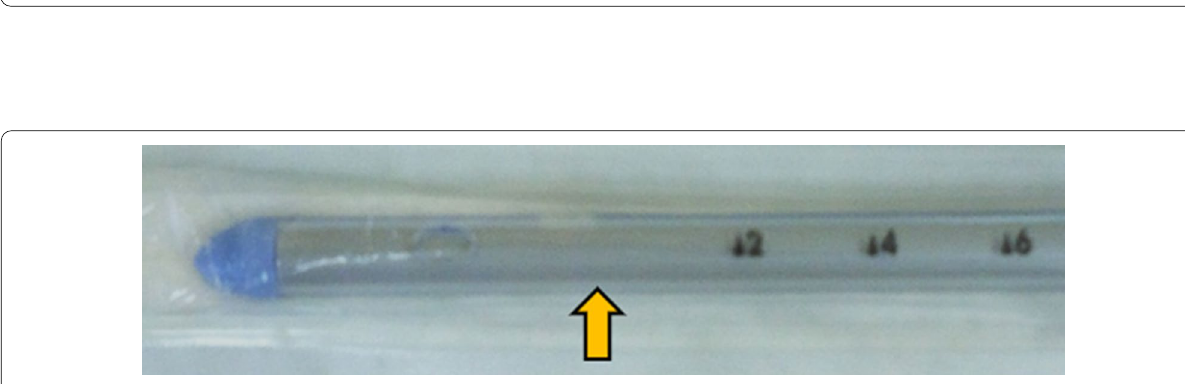
Fig.4 Tip of a 20F chest drain (Portex, UK). The distance between point zero of the scale (the first orifice) and the tip is 5 cm